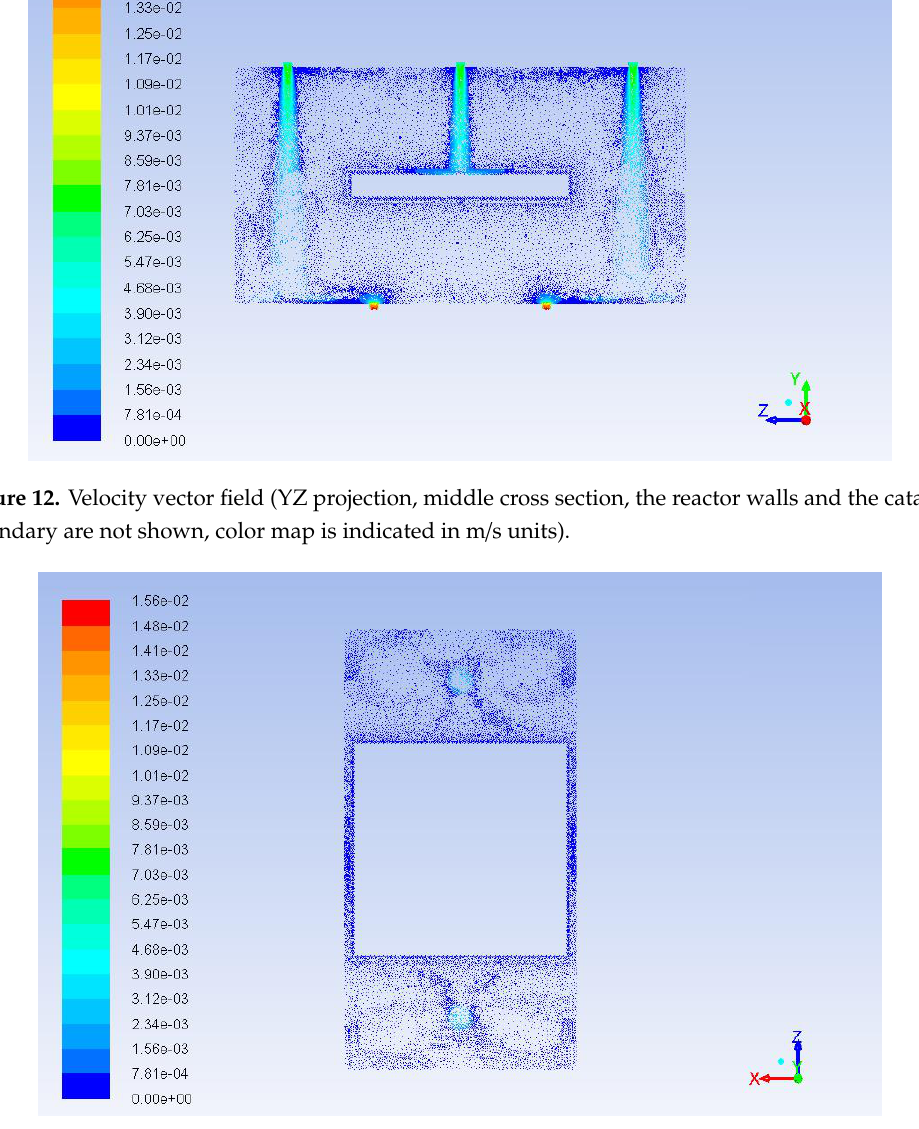
Figure 13. Velocity vector field (XZ projection, middle cross section, the reactor walls and the catalyst boundary are not shown, color map is indicated in m/s units).